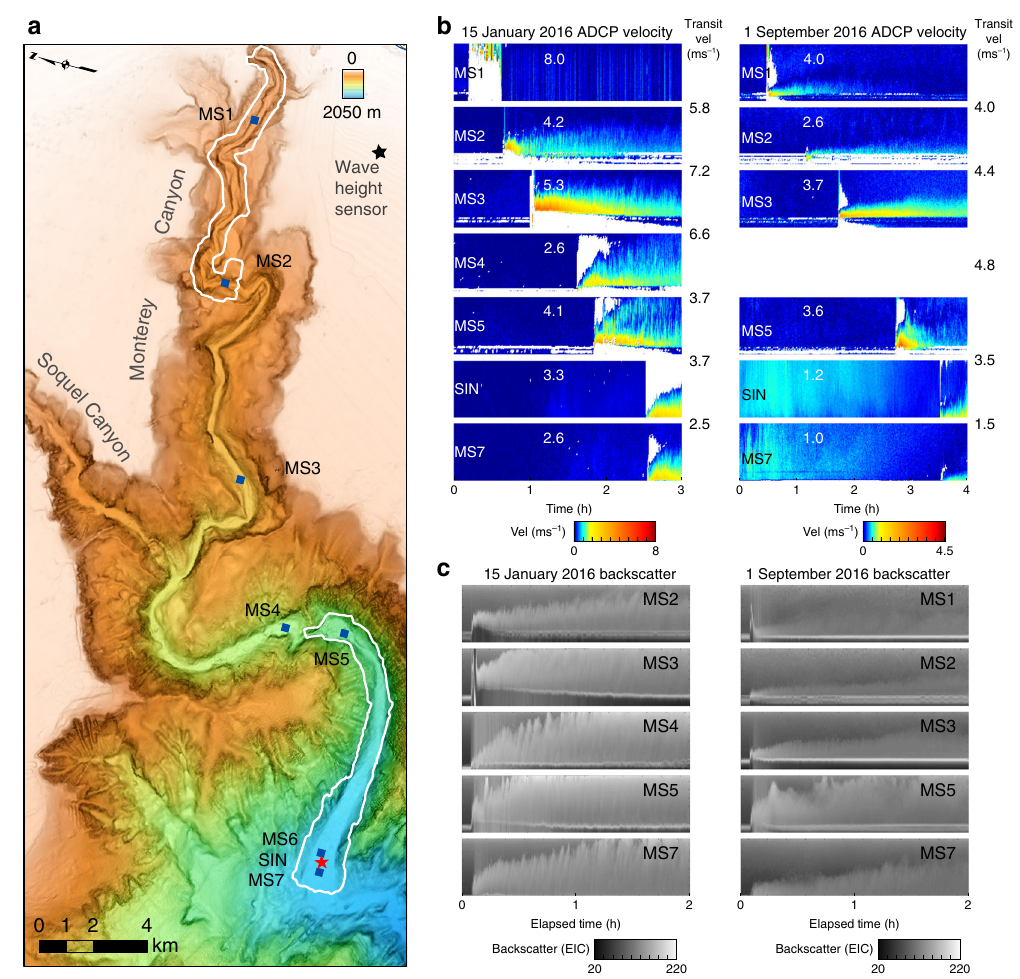
Fig. 2 Velocity and backscatter during two through-canyon fl ow events. a Map shows mooring locations with repeat mapping areas outlined in white. b ADCP-measured velocities capture the arrival of the 15 January 2016 and 1 September 2016 fl ows as they reach successive moorings within the canyon. Unresolved velocity readings are in white. Maximum ADCP-measured velocities (white numbers) and transit velocities (black numbers) are shown for comparison. c ADCP-measured backscatter, beginning 5 min before the arrival of the event, shows the evolution of the fl ow at each mooring. Echo Intensity Counts (EIC) are proportional to decibels. The ADCPs captured a 65 to 70 m range above the sea fl oor when the moorings were stable and upright. Ranges to sea fl oor decreased when the moorings were pulled downwards during